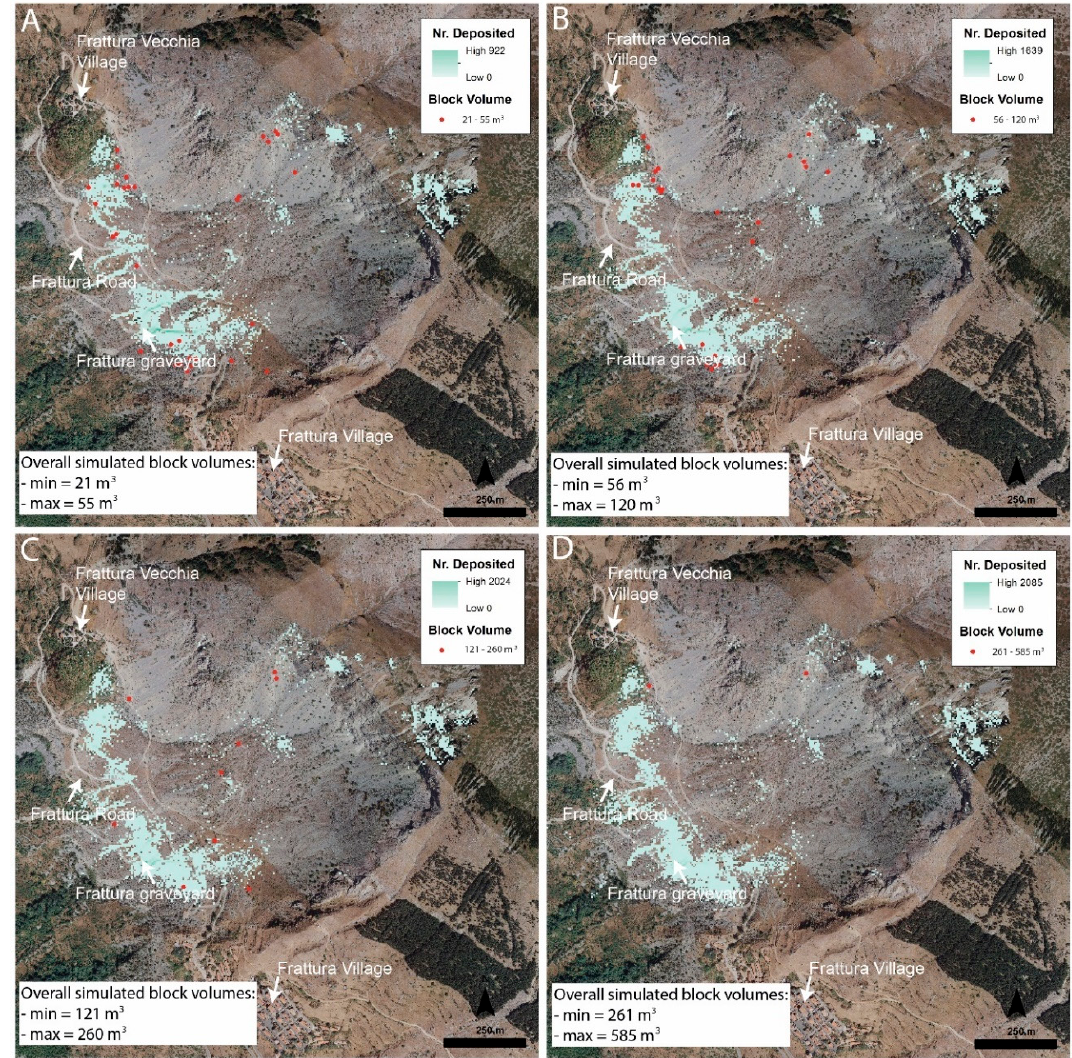
Figure 15. Results of rockfall simulations showing the number of deposited blocks (“Nr. Deposited” in the legend) when using ranges of low fracture intensity DFN 2 derived block volumes: 21–55 m 3 ( A ), 56–120 m 3 ( B ), 121–260 m 3 ( C ) and 261–585 m 3 ( D ). Red dots represent recent rockfall events with